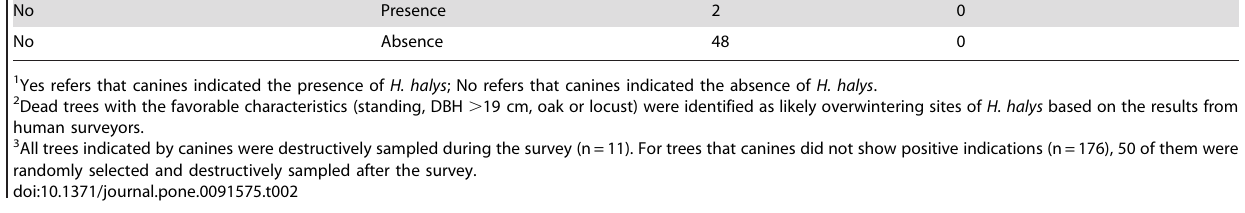
Positive indication by detector canines